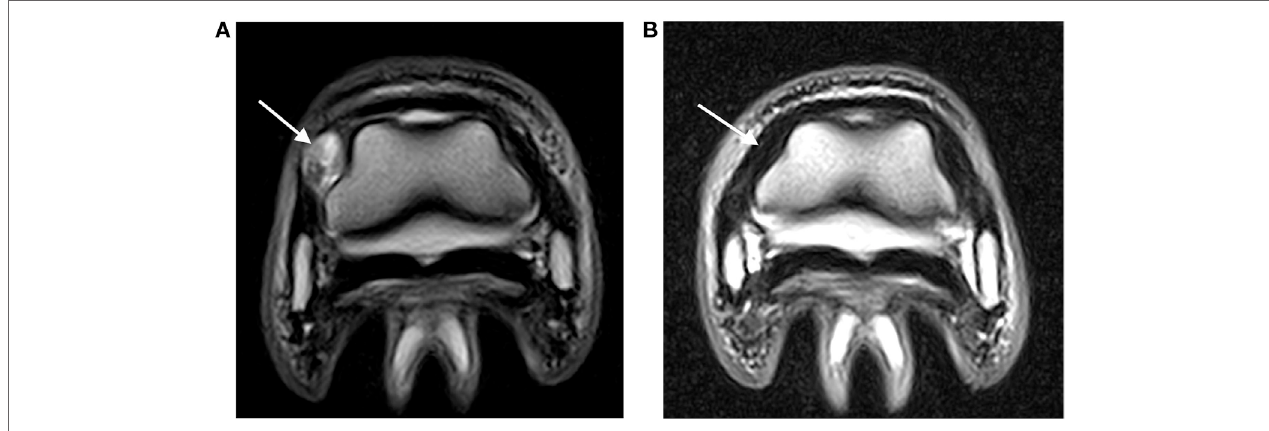
FigUre 2 | (a) Abnormal hyperintense signal (arrow) in a DIJCL prior to injection (T2-weighted fast spin echo sequence; medial is to the left). (B) Recheck MRI examination demonstrating normal signal intensity (arrow) in the same DIJCL 6 months after injection (T2-weighted fast spin echo sequence; medial is to the